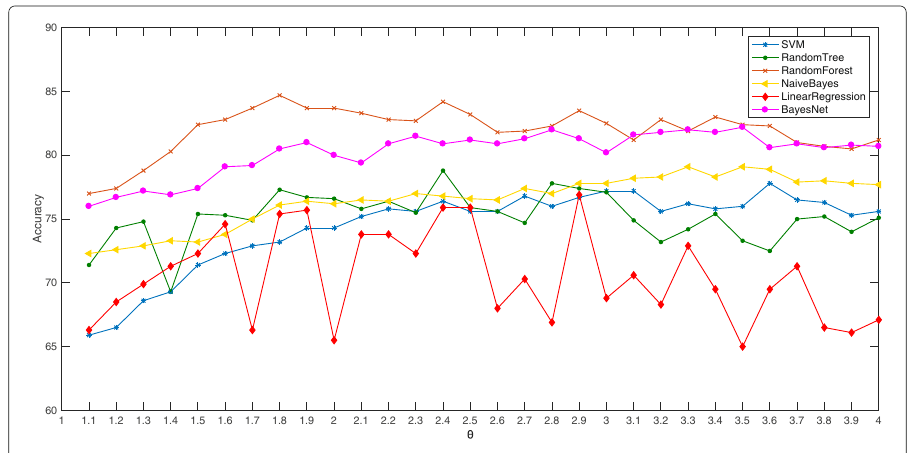
Fig. 6 Traditional statistical features experiment histogram